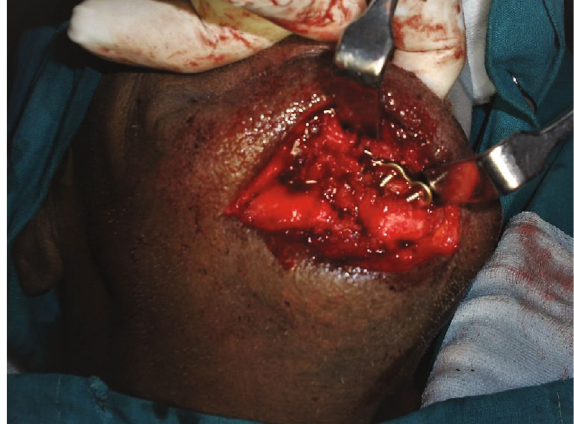
Figure 10: Extraoral markings for incision (second surgery).